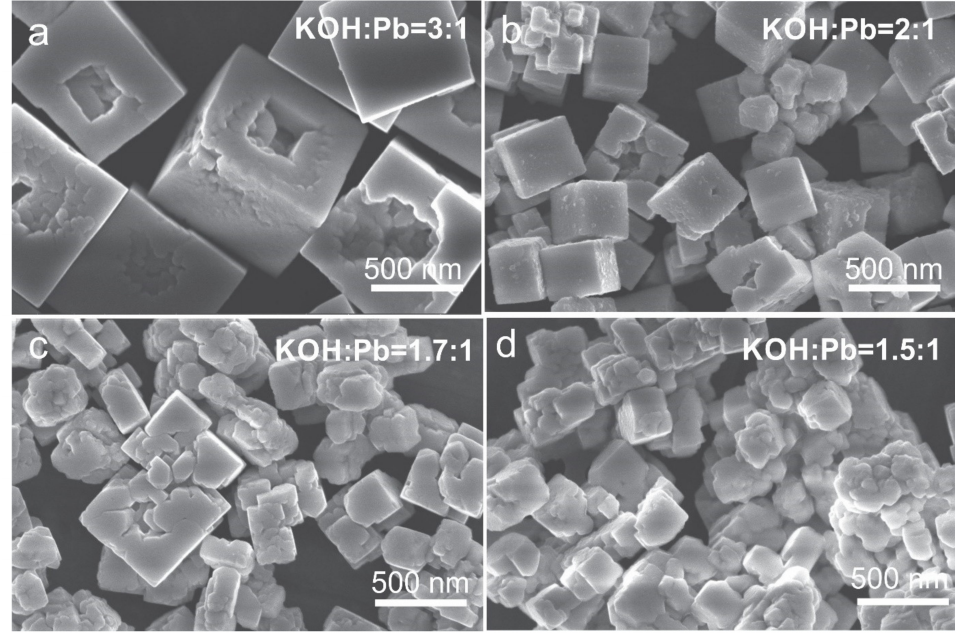
Figure 7. SEM micrographs (SE images) of the PZT07 reaction product obtained through two- step precipitation process and hydrothermal reaction at 235 ◦ C (12 h) and at ( a ) KOH:Pb = 3:1, ( b ) KOH:Pb = 2:1, ( c ) KOH:Pb = 1.7:1, and ( d ) KOH:Pb =